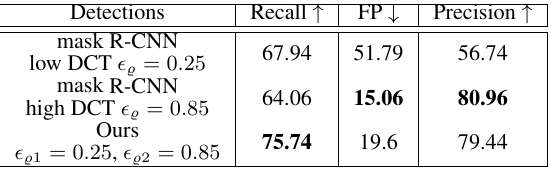
Table 2. The comparison of detection